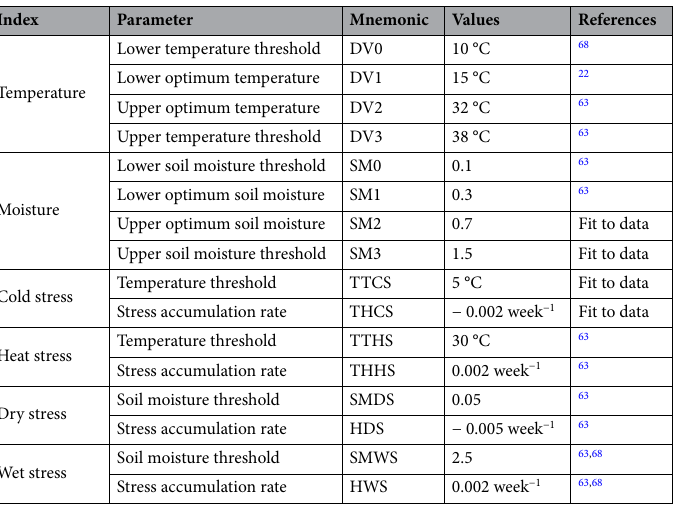
Table 1. CLIMEX parameter values are used for Trioza